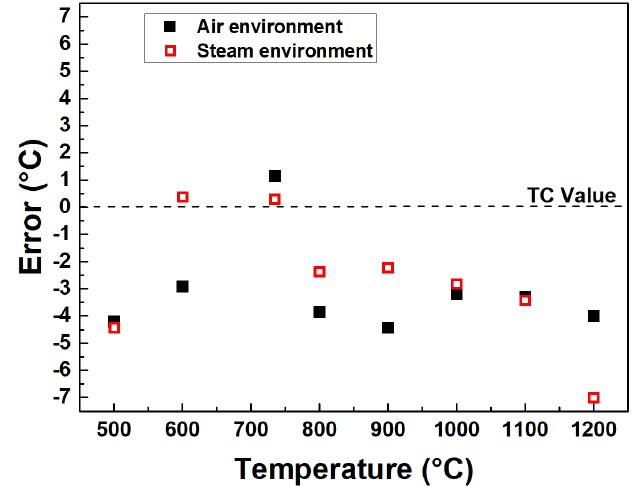
Figure 2. Temperature values measured in air (black marks) and steam (red marks) environments compared to internal thermo- couple values (red dash line) on Zircaloy-4